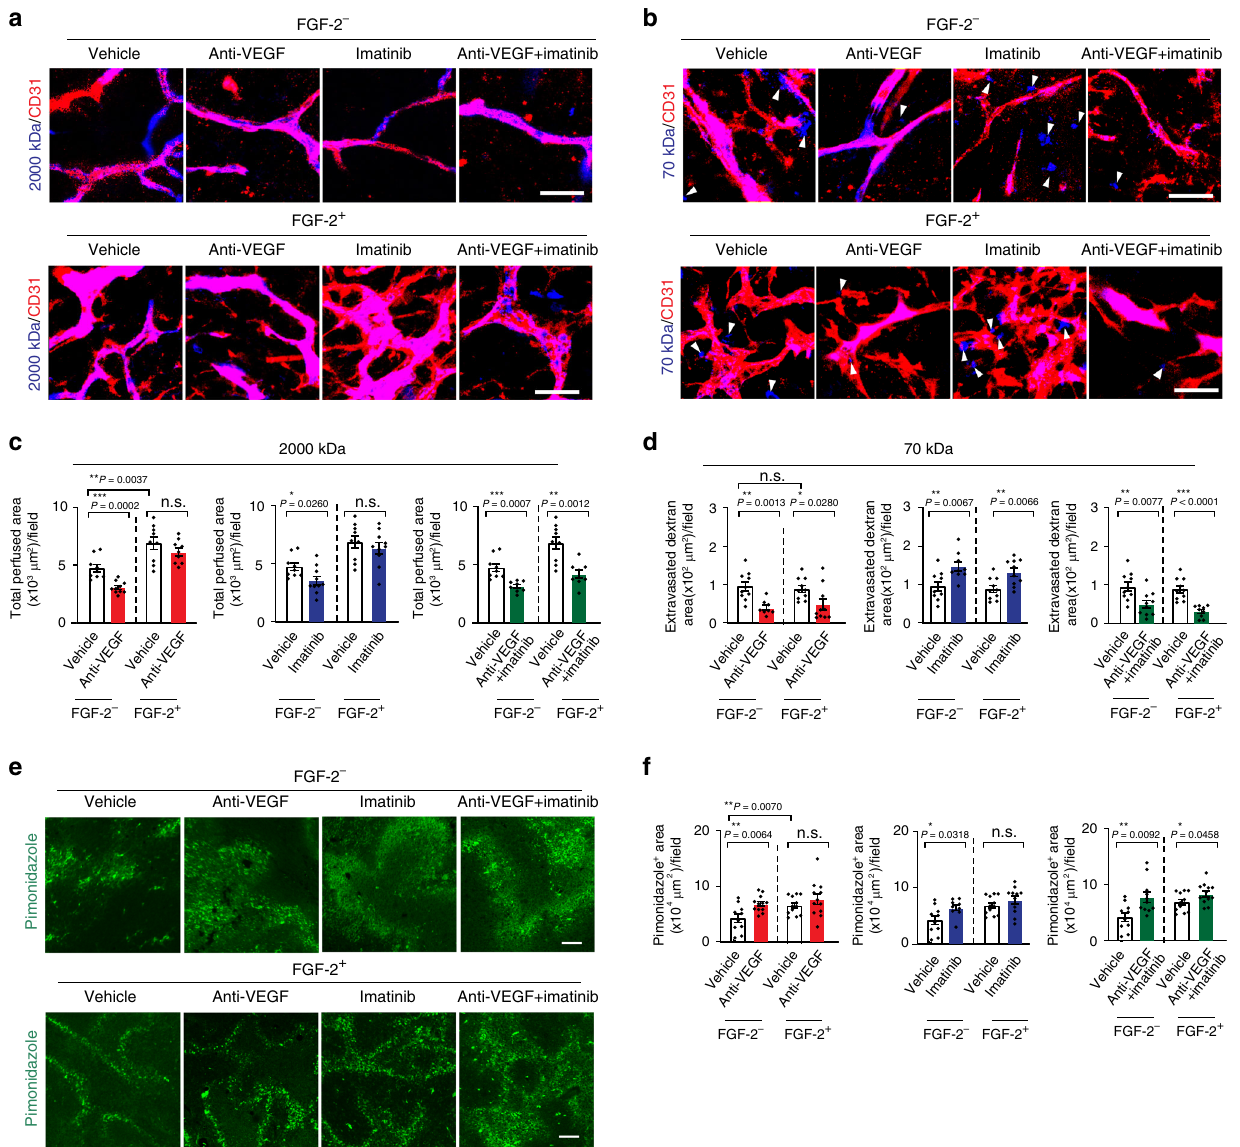
Fig. 2 Vascular perfusion, vascular permeability, and tumor hypoxia. a Vascular perfusion of Rhodamine-labeled lysinated 2000 kDa dextran (blue) of various monotherapy- and combination therapy-treated E0771-vector and E0771-FGF-2 breast cancers. Red indicates CD31 + microvessels. Bar = 50 μ m. b Vascular permeability of Rhodamine-labeled lysinated 70 kDa dextran (blue) of various monotherapy- and combination therapy-treated E0771-vector and E0771-FGF-2 breast cancers. Red indicates CD31 + microvessels. Bar = 50 μ m. Arrowheads indicate extravasation of 70 kDa dextran from the tumor vasculature. c Quanti fi cation of vascular perfusion of vehicle-, anti-VEGF-, imatinib- and combination therapy-treated E0771-vector and E0771-FGF-2 breast cancers ( n (Vector) = 9/10/10/8; n (FGF-2) = 9/9/10/8; P (Vector vs FGF-2) = 0.0037; P (Vehicle-treated vector vs anti-VEGF-treated vector) = 0.0002; P (Vehicle-treated vector vs imatinib-treated vector) = 0.0260; P (Vehicle-treated vector vs combination therapy-treated vector) = 0.0007; P (Vehicle-treated FGF-2 vs combination therapy-treated FGF-2) = 0.0012). d Quanti fi cation of vascular permeability of vehicle-, anti-VEGF-, imatinib- and combination therapy-treated E0771-vector and E0771-FGF-2 breast cancers ( n (Vector) = 10/8/9/10; n(FGF-2) = 10/10/10/9). P (Vehicle-treated vector vs anti-VEGF-treated vector) = 0.0013, P (Vehicle-treated FGF-2 vs anti-VEGF-treated FGF-2) = 0.0280, P (Vehicle-treated vector vs imatinib-treated vector) = 0.0067, P (Vehicle-treated FGF-2 vs imatinib-treated FGF-2) = 0.0066, P (Vehicle-treated vector vs combination therapy-treated vector)